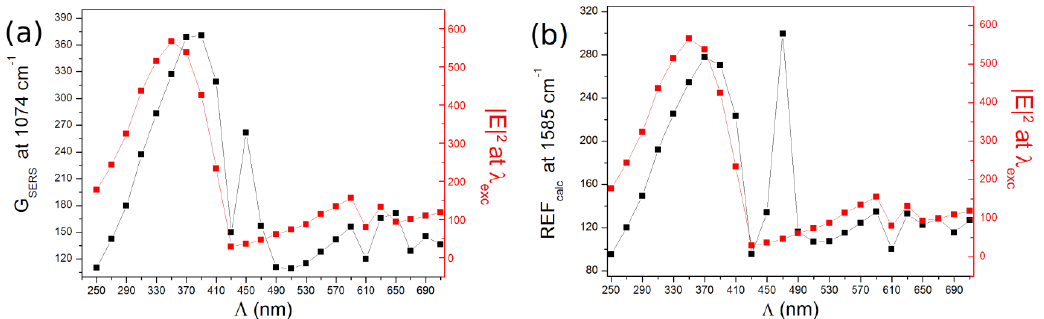
Figure 4. Calculated Raman enhancement factor (REF calc ) versus the grating constant for the Raman line at 1074 cm − 1 ( a ) and 1585 cm − 1 ( b ). The REFs are superposed with | E( ω exc ) | 4 , calculated at 633 nm. The calculation are made for gold nanodiscs arrays with a diameter of D = 100 nm. The height of nanodiscs is h = 50